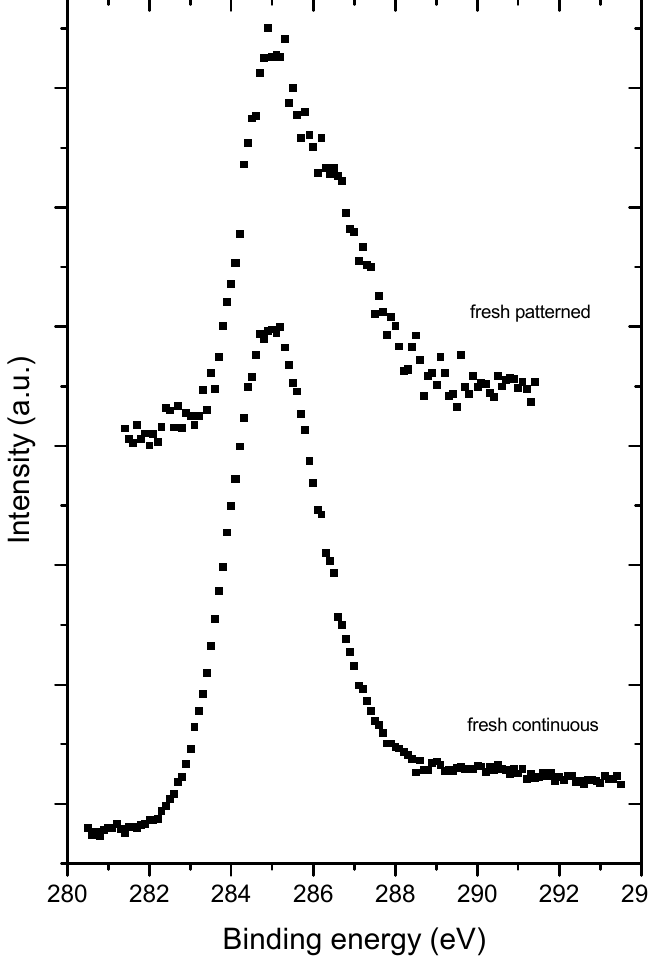
Table 1. Quantitative analysis of the surface of the tested samples. Sample